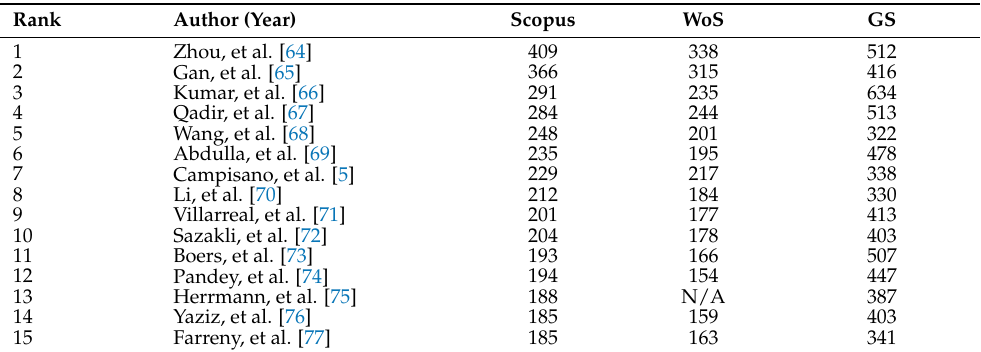
Table 11. The most frequently cited articles on RWH related studies from different databases (accessed on 31 January